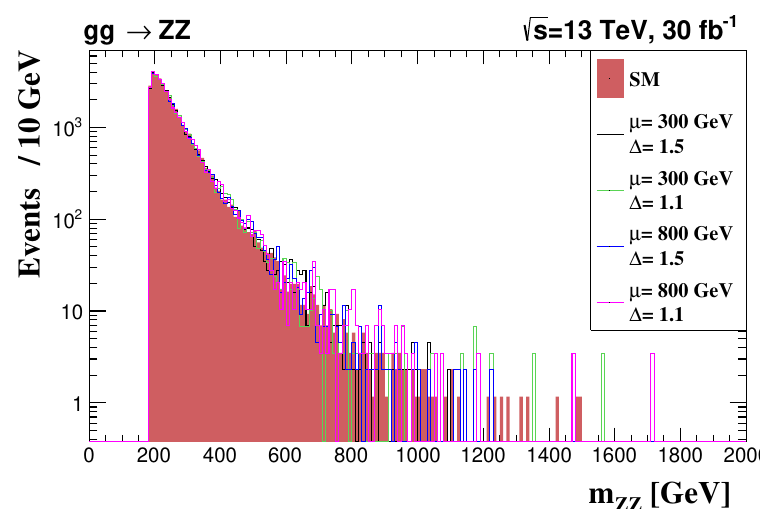
Figure 10. With the inclusion of i(cid:15) in the form factor (explained in the text), the strong deviation from SM above the threshold, (cid:22) , vanishes. The (cid:13)uctuation observed in the graph are due to using small number of events in MG. The Z ’s are on-shell and with a cut on the Z transverse momentum: p T > 1GeV. (Color online).